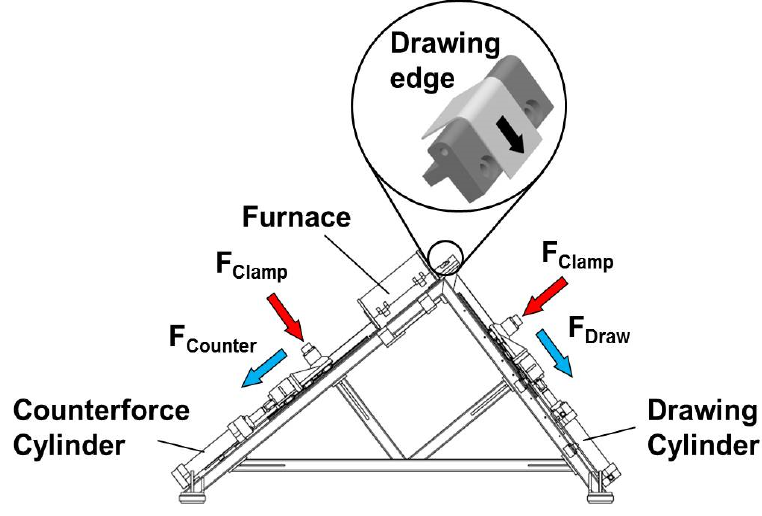
Figure 3. Scheme of Strip Drawing Machine developed at Fraunhofer IWU.